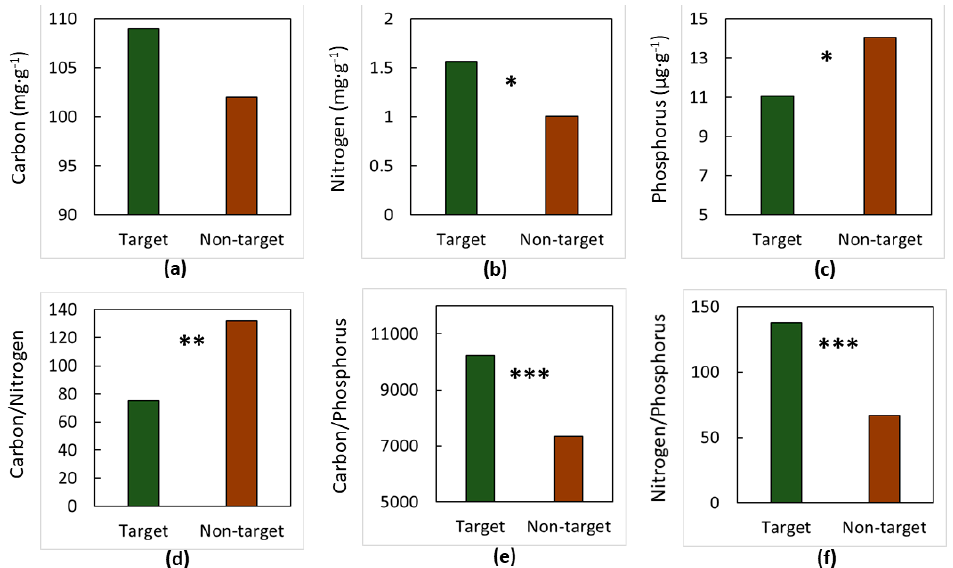
Figure 5. The influence of proximity to Cycas micronesica on soil chemical traits in Shioya sand soils on Rota. Target soils were collected underneath cycad trees. Non-target soils were collected 5-m from focal cycad trees. ( a ) Total carbon; ( b ) Total nitrogen; ( c ) Olsen phosphorus; ( d ) Carbon/nitrogen; ( e ) Carbon/phosphorus; and, ( f ) Nitrogen/phosphorus. *, **, *** = significant at 0.05, 0.01, or 0.001.